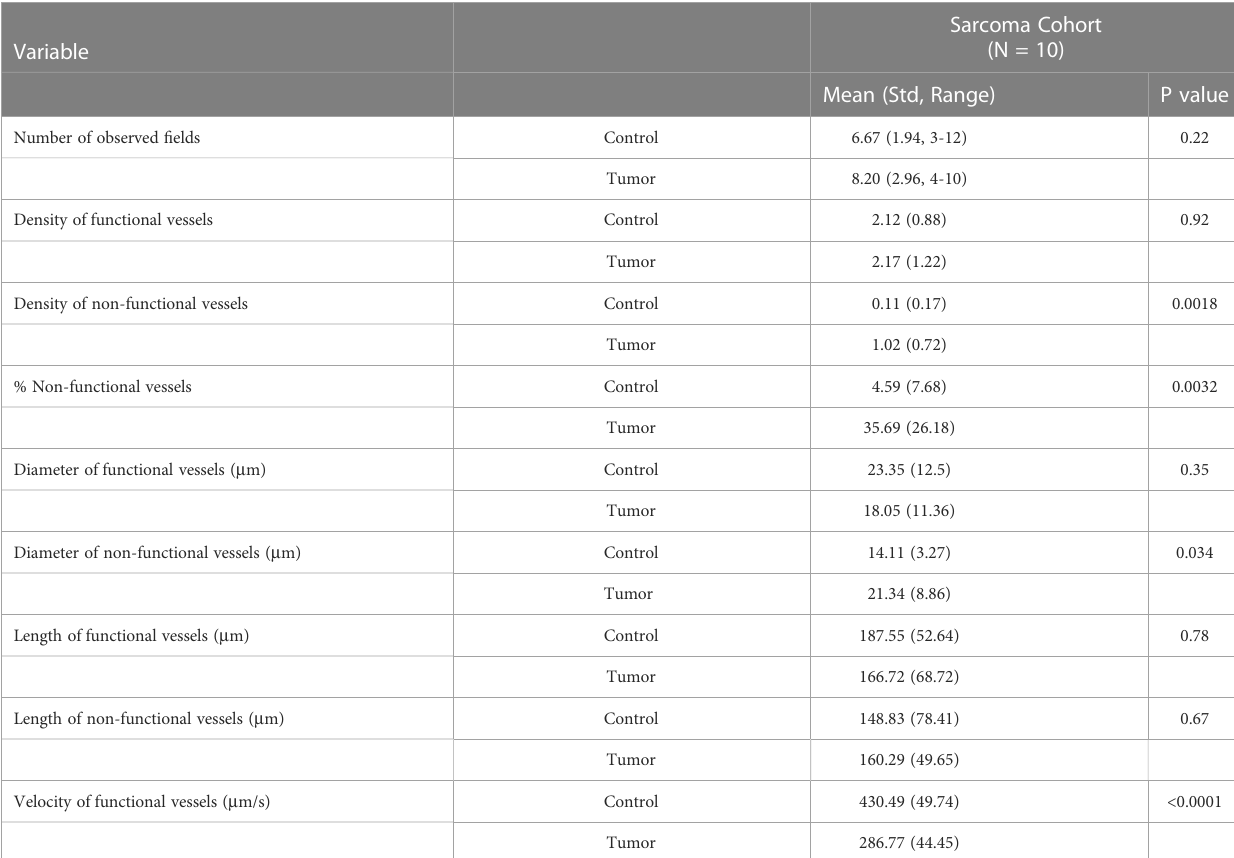
TABLE 2 Comparison of tumor and non-tumor (control) vessel characteristics during intravital microscopic